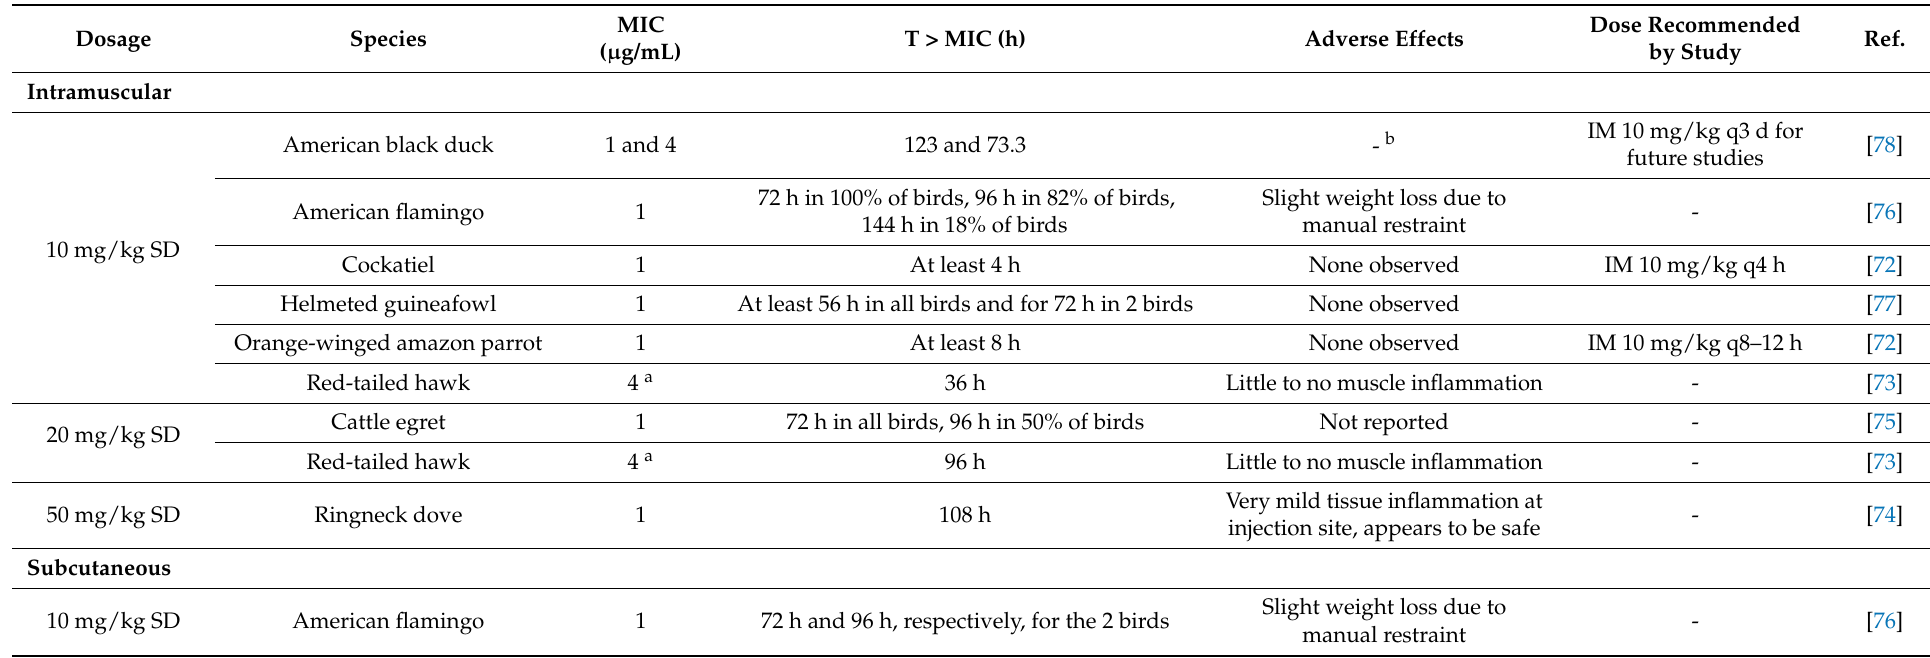
Table 10. Adverse effects, efficacy parameters, and dosage recommendations of ceftiofur in exotic avian